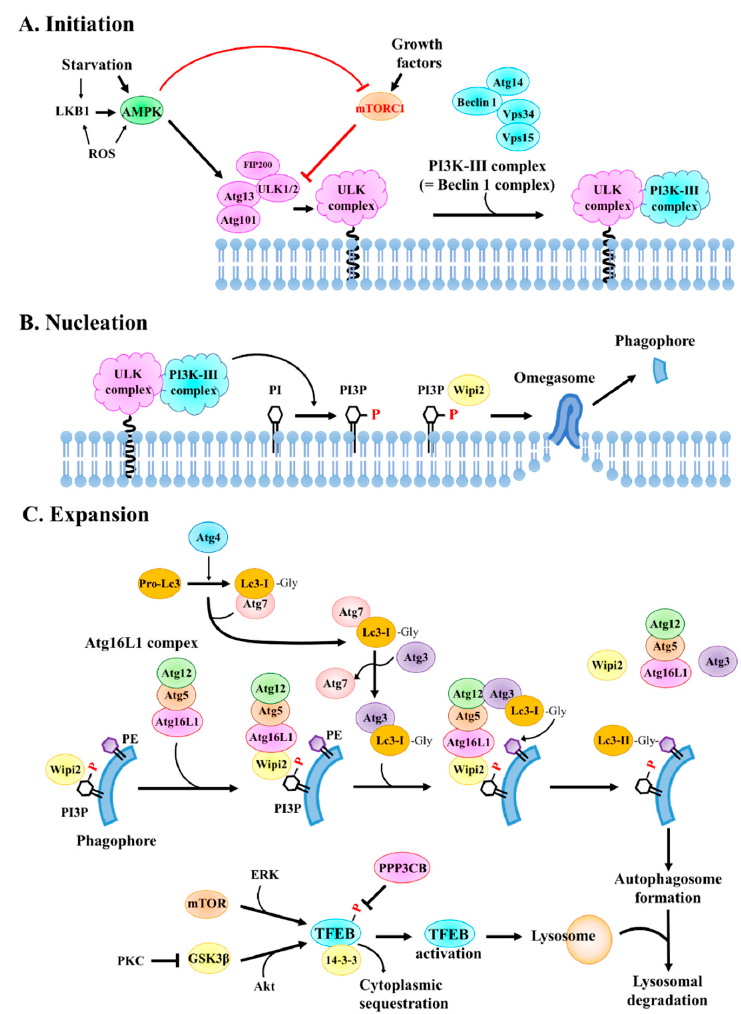
Figure 2. Autophagosome formation. Autophagosome formation can be divided into three stages. ( A ) During initiation, the UNC51-like kinase (ULK) complex is dissociated from mTORC1 and binds to the autophagosome initiation site. The ULK complex recruits and phosphorylates the class III phosphoinositide 3-kinase (PI3K-III) complex. ( B ) During nucleation, the PI3K-III complex generates phosphatidylinositol 3,4,5-triphosphate (PI3P) on the membrane and recruits autophagy-specific PI3P effectors, such as WD-repeat domain phosphoinositide-interacting 2 (Wipi2). The interaction of PI3P with Wipi2 contributes to the phagophore formation. ( C ) During expansion (elongation), the Atg12-Atg5-Atg16L1 complex (also known as the Atg16L1 complex) is recruited to the membrane and lipidates microtubule-associated proteins 1 light chain 3 (Lc3). The pro-form of Lc3 is cleaved at the carboxyl-terminal (C-terminal) by Atg4 and becomes cytosolic Lc3-I, thereby exposing the C-terminal glycine residue. Lc3-I is subsequently transferred to the autophagosome by Atg3 and conjugated with phosphatidylethanolamine (PE) at the C-terminal glycine residue by the Atg16L1 complex, resulting in the formation of Lc3-II. During the autophagy process, Lc3-II bound to the autophagosomal inner membrane is degraded by lysosomal enzymes. The expression of genes related to lysosomal biogenesis and autophagolysosome formation is controlled by a master transcriptional regulator, TFEB. Abbreviations: AMPK, AMP-activated protein kinase; Atg, autophagy-related gene; ERK, extracellular signal-regulated kinase; LKB1, liver kinase B1; GSK3 β , glycogen synthase kinase-3 β ; mTOR, mechanistic target of rapamycin kinase; PKC, protein kinase C; PPP3CB, protein phosphatase 3 catalytic subunit beta; TFEB, transcription factor EB; Vps, vacuolar protein